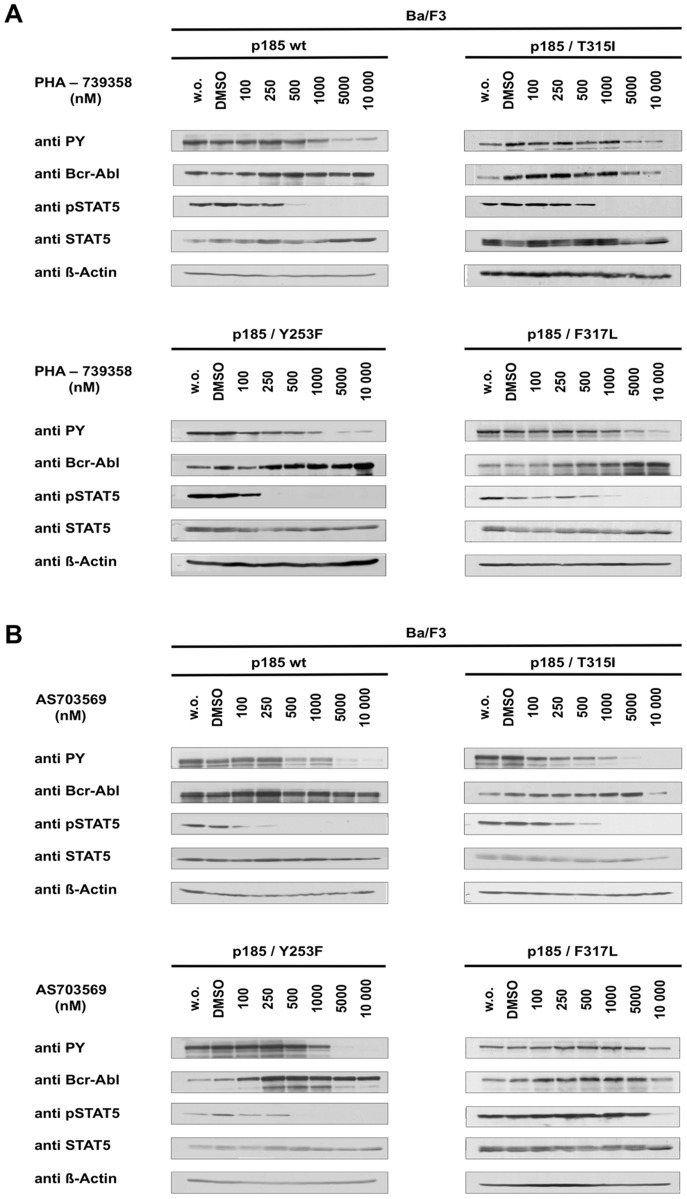
PHA-739358 and R763/AS703569 reduce BCR-ABL kinase activity at comparable concentrations and independent of the BCR-ABL mutation status.Ba/F3 p185 wt and IM-resistant T315I, Y253F, and F317L mutants cells were exposed to increasing concentrations of PHA-739358 (A) or R763/AS703569 (B) for 2.5 h and assessed for phosphorylation status of BCR-ABL and its downstream target STAT5 by western blot analysis. Untreated and DMSO treated cells were used as a controls.